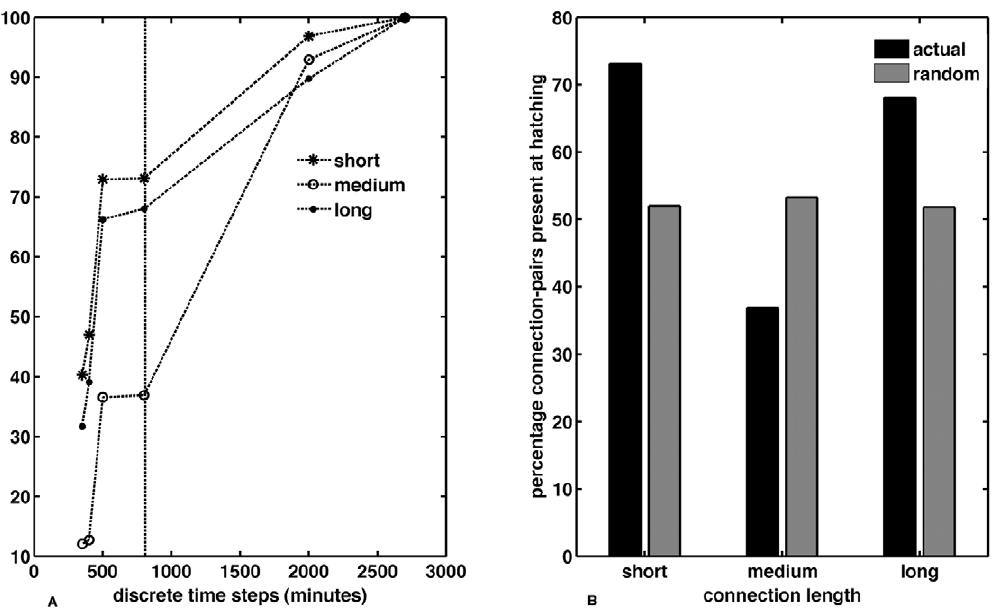
Figure 4. Variation in the growth of short, medium and long-range connection-pairs during development, compared against random networks (discrete time steps). (A) Percentage of each type of connection-pairs appearing during development. Percentage is with respect to the total number of connections of that type (short, medium or long) in the adult. The black vertical dashed line represents the time of hatching. (B) Comparison with random networks, of the percentage of each category of connection-pairs appearing before hatching.